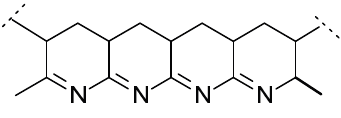
Figure 3. Cyclic structures formed due to intramolecular cyclization in